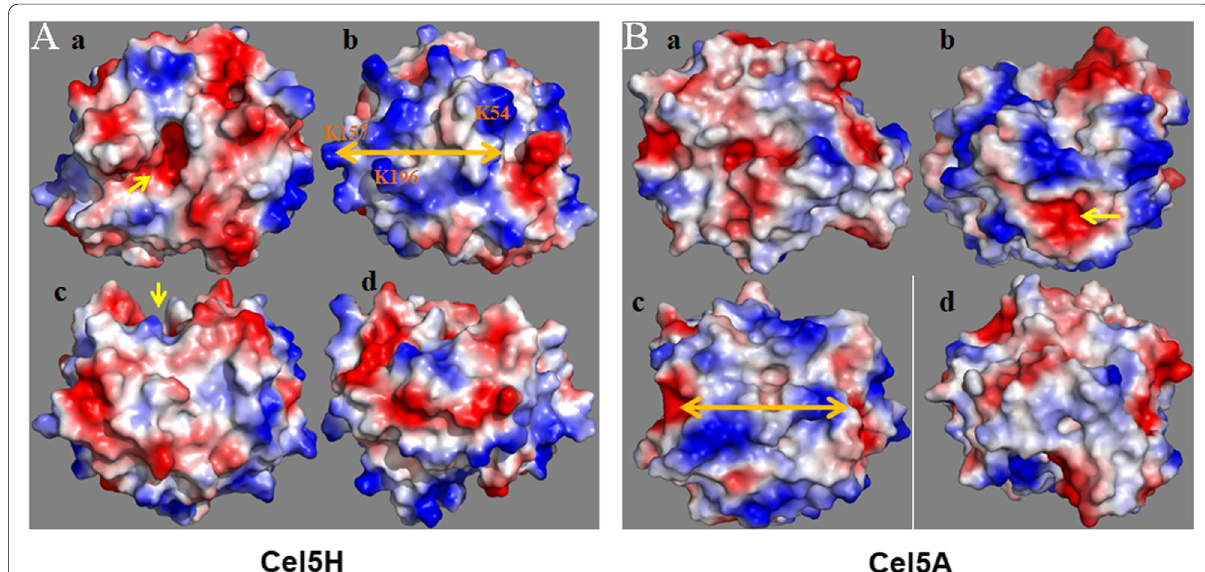
Fig. 4 Electrostatic potential energy surfaces of the Cel5H (panel A ) and Cel5A (panel B ) proteins. Also, proposed clay mineral and substrate binding sites of the Bacillus licheniformis protein (indicated by arrows). Panel A & B . Views of the front and back side electrostatic surfaces of Cel5H protein (a and b). Views of side electrostatic energy surface of Cel5H protein (c and d), blue is electropositive and red is electronegative. Panel B , different views of Cel5A protein, front and back view (a and b), side view (c and d). Substrate binding groove (